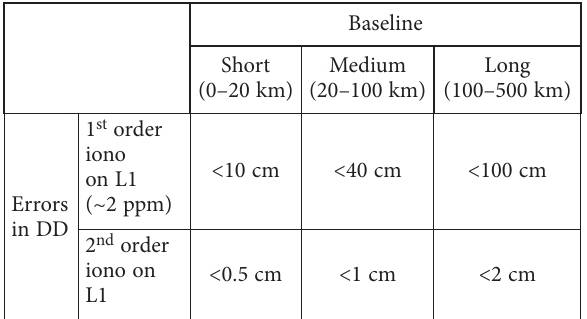
Table 1. Standard deviations of ionospheric delays in DD for short, medium and long